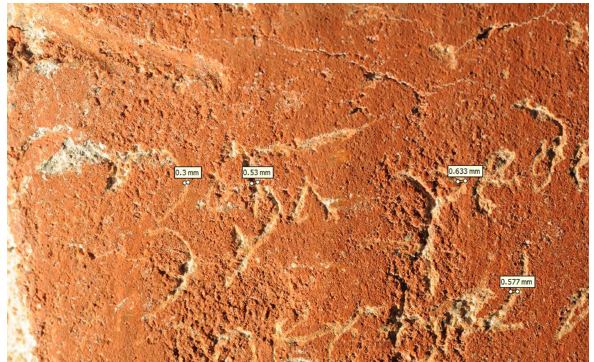
Figure 7. Measurements of graffiti lines performed on single cameras in